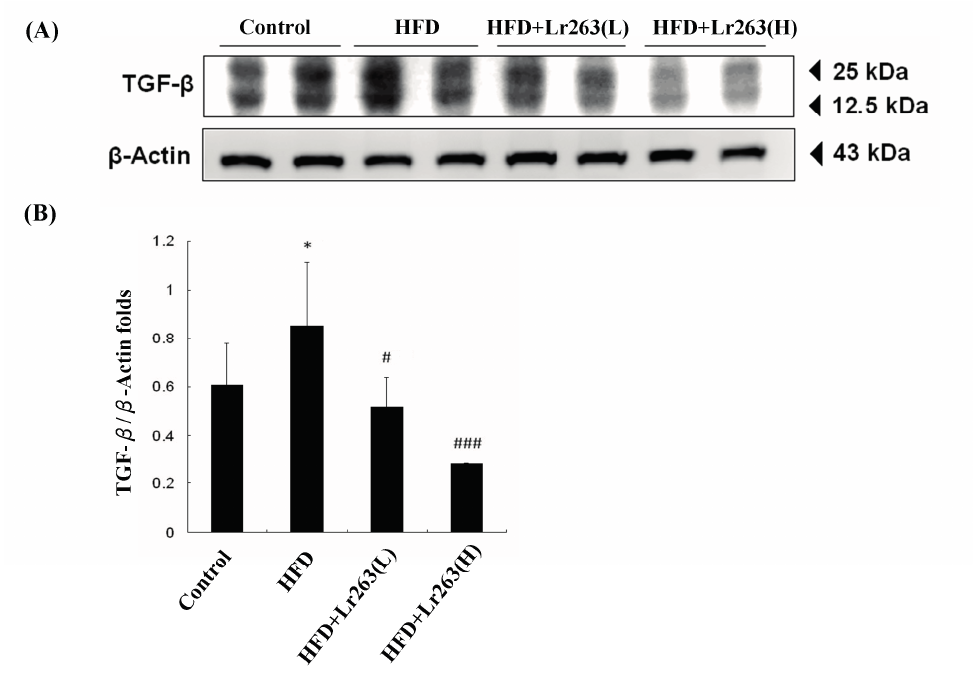
Figure 3. TGF- β protein levels in animal livers. ( A ) High TGF- β expression was observed only in the HFD group hamster livers; ( B ) The normalized protein expression of TGF- β with β -actin (* p < 0.05 compared with the control group, # p < 0.05, and ### p < 0.001 compared with the HFD group). Table 1. The body weight, food intake, lipid profile of hamster livers and fecal analyses.